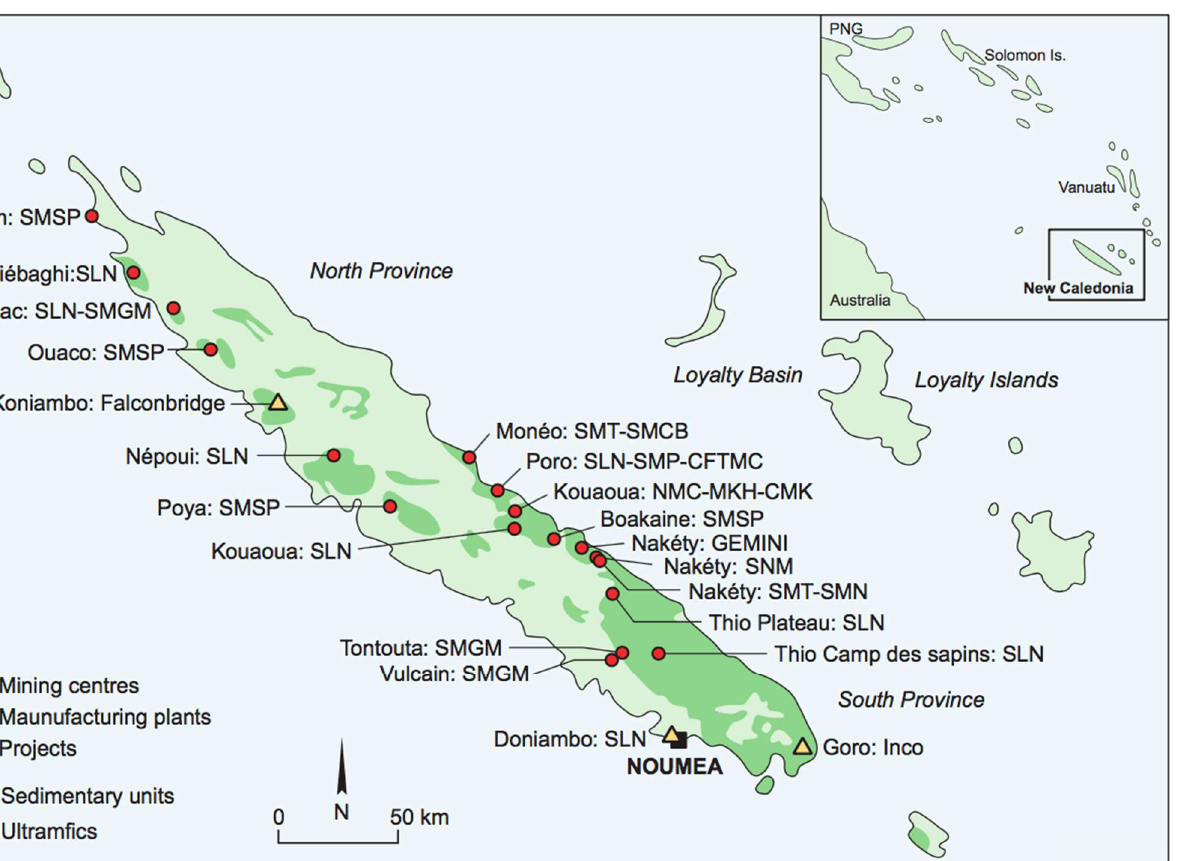
Table 1. Interpretation of geological domaining samples.